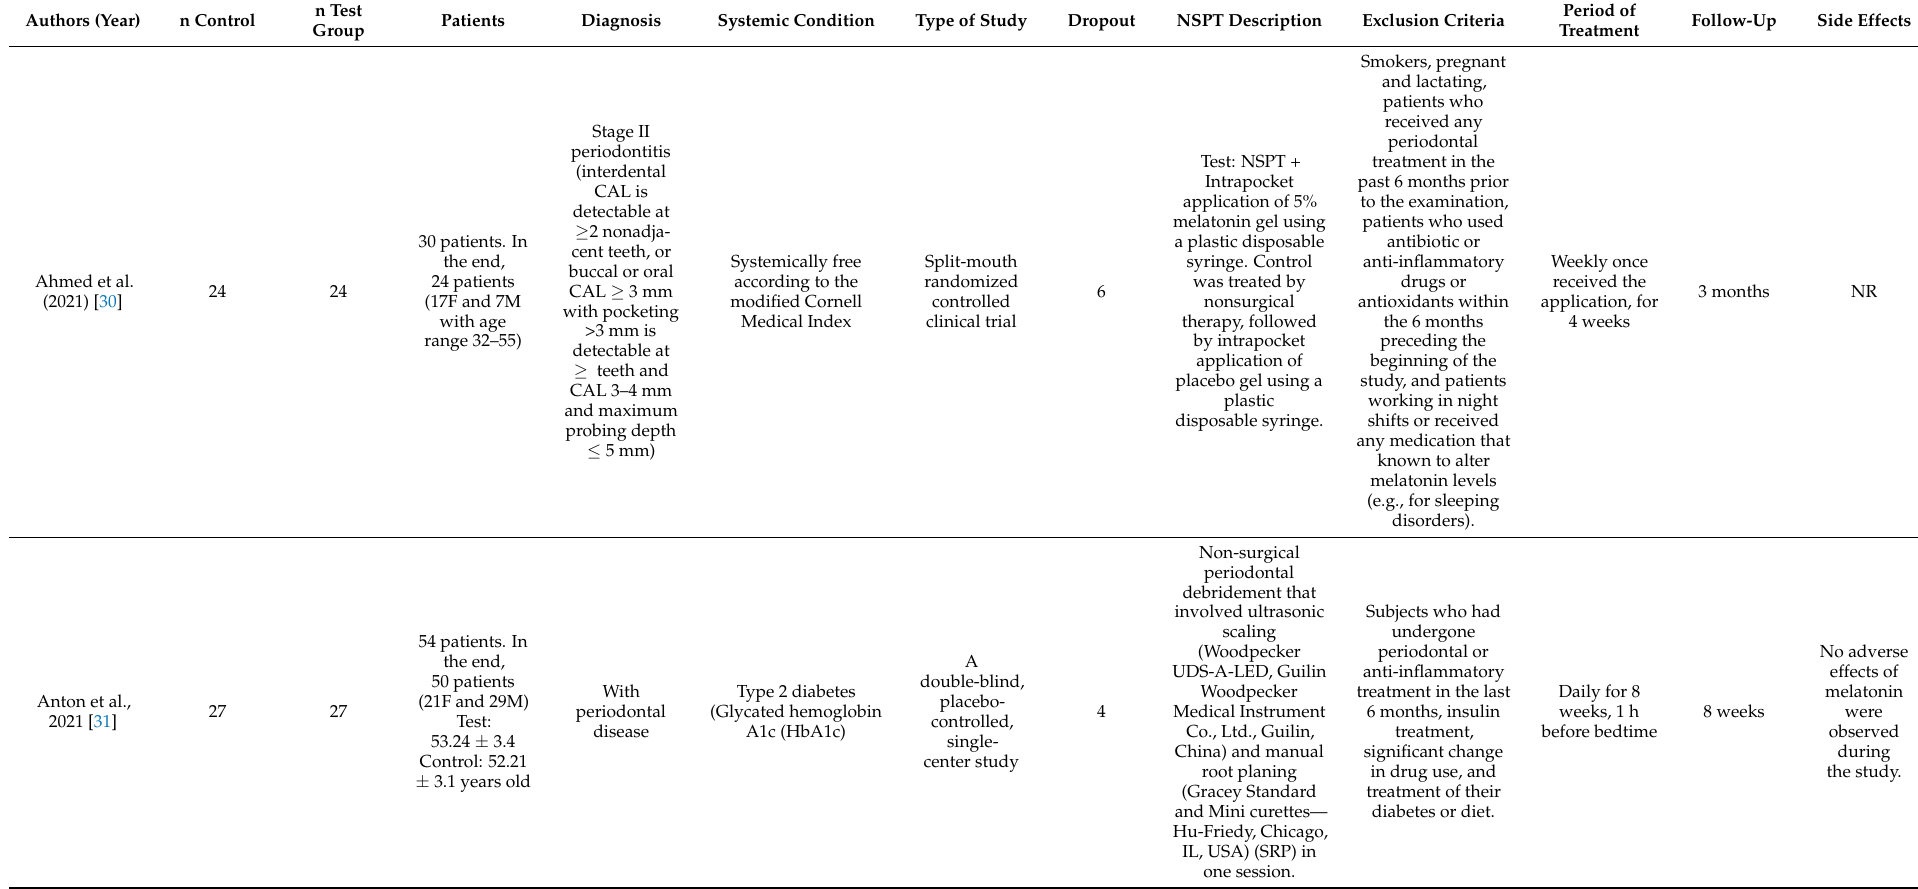
Table 2. General data of the included